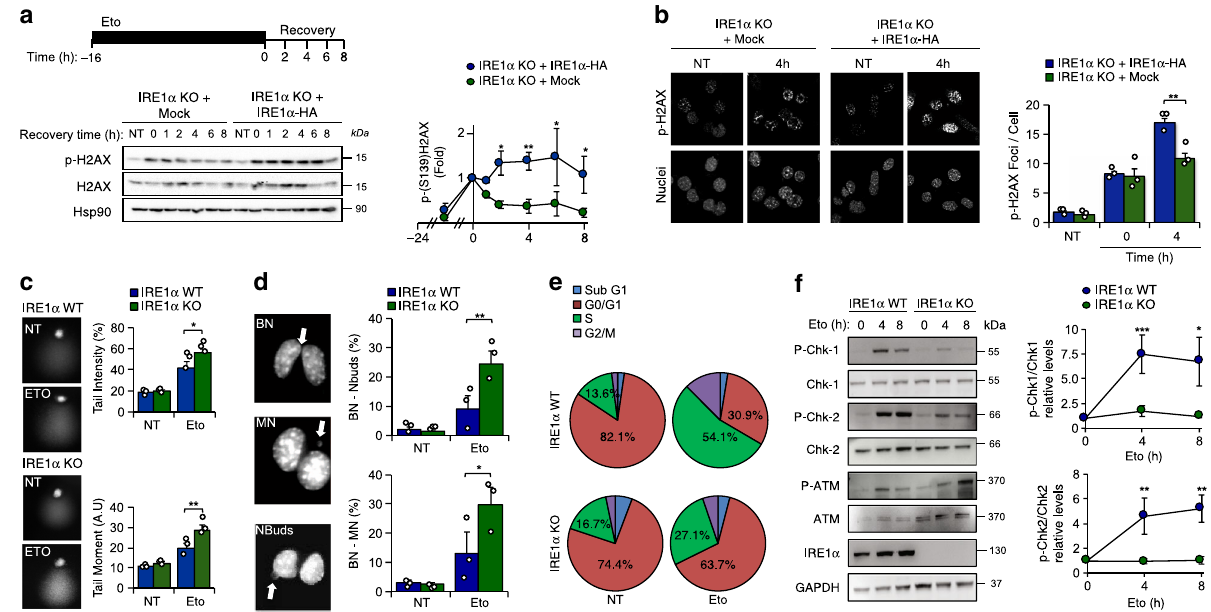
Fig. 2 IRE1 α de fi ciency impairs the DDR. a IRE1 α KO (Mock) and IRE1 α -HA reconstituted cells were pre-incubated with 1 μ M etoposide (Eto) for 16 h and washed three times with PBS and fresh cell culture media was added. The decay of phosphorylated H2AX (P-H2AX) was monitored over time by western blot (middle panel). Quanti fi cation of the levels of P-H2AX in cells stimulated with Eto (bottom panel) ( n = 3). b IRE1 α KO (Mock) and IRE1 α -HA reconstituted cells were incubated with 10 μ M Eto for 2 h and then washed with PBS and fresh culture media was added. The distribution P-H2AX expression (green) was monitored by indirect immuno fl uorescence using confocal microscopy. Nuclei were staining with DAPI (Blue). Quanti fi cation of P-H2AX per cell is shown (right panel) ( n = 3). c WT and IRE1 α KO MEFs cells were treated with 10 µ M Eto for 3 h to perform the comet assay. Quanti fi cation of tail intensity and tail moment (Tail intensity × tail area) is shown (right panel) ( n = 3). d WT and IRE1 α KO MEFs cells were treated with 5 μ M Eto for 3 h to determined cytokinesis-block micronucleus cytome assay (CBMC). Binucleated cells (BN) with micronucleus (MN), nuclear buds (Nbuds) or nucleoplasmid bridges (NPB; see arrows) were visualized and quanti fi ed using epi fl uorescence microscopy ( n = 3). e WT and IRE1 α KO MEFs cells were treated with 10 μ M Eto for 8 h and cell cycle was analyzed by propidium iodide (PI) staining. Quanti fi cation of the percentage of cells in G0/G1 and S phases is shown. f WT and IRE1 α KO MEFs cells were treated with 10 μ M Eto for indicated times. Expression and phosphorylation levels of indicated proteins involved in the DDR were monitored by western blot (left panel). Quanti fi cation of the levels of p-CHK1 and p-CHK2 is shown (right panel) ( n = 3). In all panels, data is shown as mean ± s.e.m.; * p < 0.05, ** p < 0.01, and *** p < 0.001, based on ( a , c , d , f ) two-way ANOVA followed Bonferroni ’ s test, b two-way ANOVA followed Tukey ’ s test. Data is provided as a Source Data fi